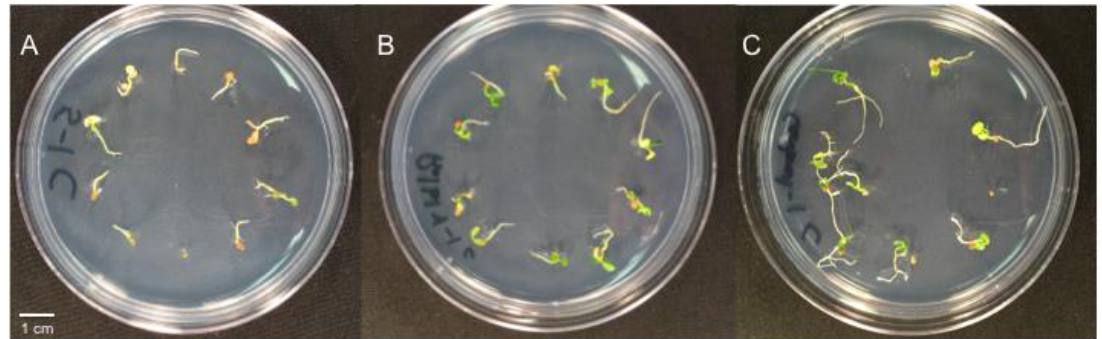
Figure 2. Trifolium repens seedlings 14 days after inoculation with Pantoea sp. Isolate 5 ( A ), Pantoea sp. Isolate RiLB4 (positive control) ( B ), and bacteria free control ( C ). Cotyledons inoculated with isolate 5 are pale and necrotic compared to the positive and bacteria free controls.